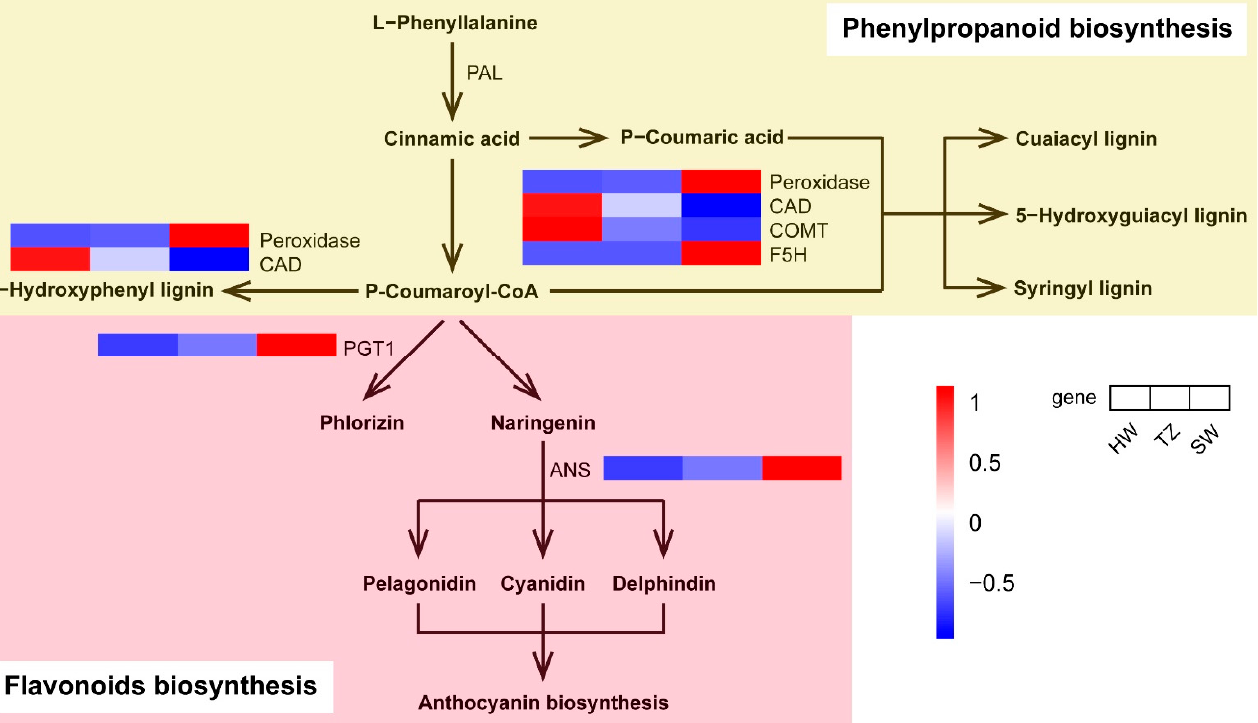
Figure 7. Transcript profiling of genes in the phenylpropanoid and flavonoid biosynthesis pathways among HW, TZ, and SW. PAL, phenylalanine ammonia-lyase; CAD, cinnamyl-alcohol dehydrogenase; COMT, caffeic acid 3-O-methyltransferase/acetylserotonin O-methyltransferase; F5H, ferulate-5-hydroxylase; PGT1, phlorizin synthase; and ANS, anthocyanidin synthase.